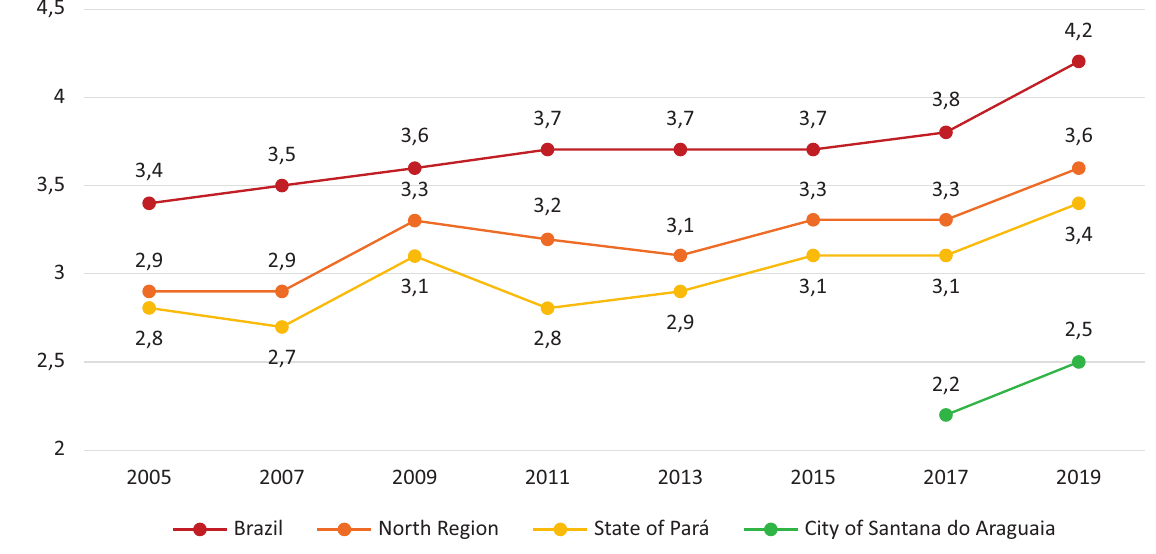
Figure 5. IDEB in high school in the public network. Source: INEP